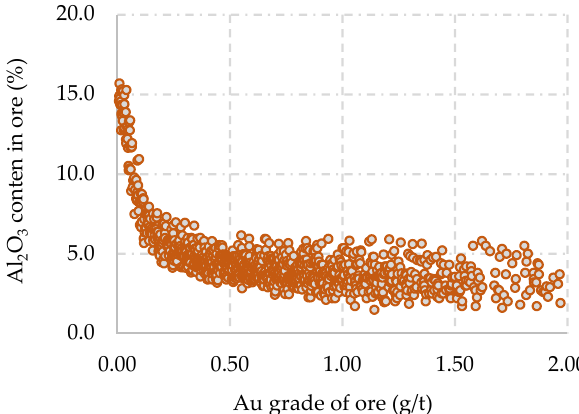
Figure 6. Scatterplot of arsenic content and total gold recovery.